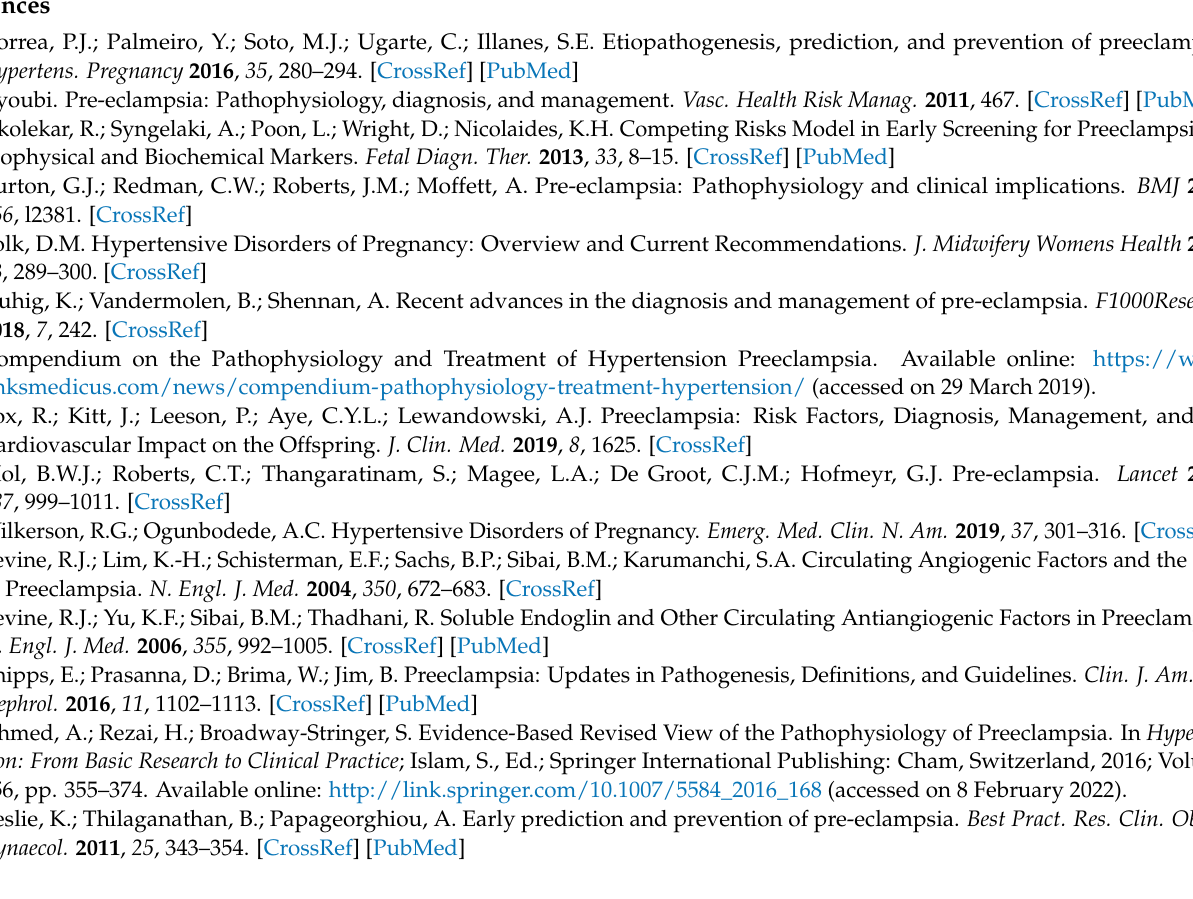
Table S4: Evaluation of the eligible case-control studies with Newcastle-Ottawa scale; Table S5: Evaluation of the eligible cohort studies with Newcastle-Ottawa scale; Table S6: Results of the meta- analyses examining the association between pre-eclampsia during pregnancy and cerebral palsy in the offspring; subgroup analyses by degree of adjustment, study design, geographic region, overall quality rating; Table S7: The Preferred Reporting Items for Systematic Reviews and Meta-Analyses (PRISMA)